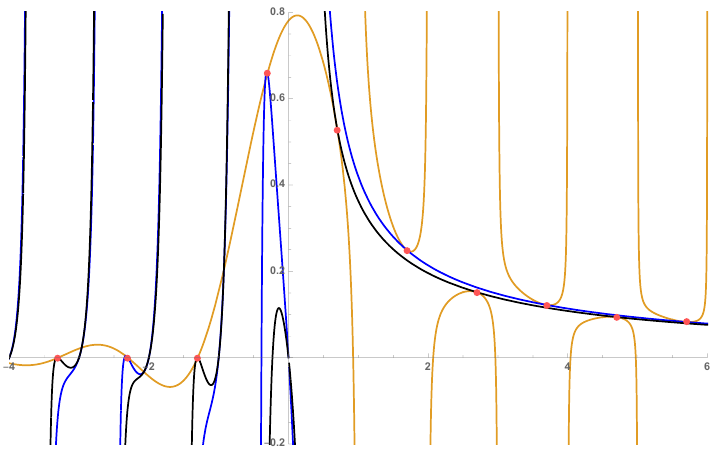
Figure 4 . A visualization of equation (4.32) corresponding to the equivalence of the two inversion formulas for z p (1 − z ) − q with p = 0 . 2 and q = 0 . 3 . The orange curve is the left-hand side, so ˇ f ( α ) , and the blue and black curves are the two expressions on the right-hand side, so ˇ f ( t ) ( α ) + ˇ f ( u ) ( α ) and ˇ f ( t ) ( α ) − ˇ f ( u ) ( α ) . As indicated by the red dots, we find agreement for α = p + m − 1 / 2 where the correct λ m are reproduced. (For clarity of presentation we have divided all functions by 4 − α